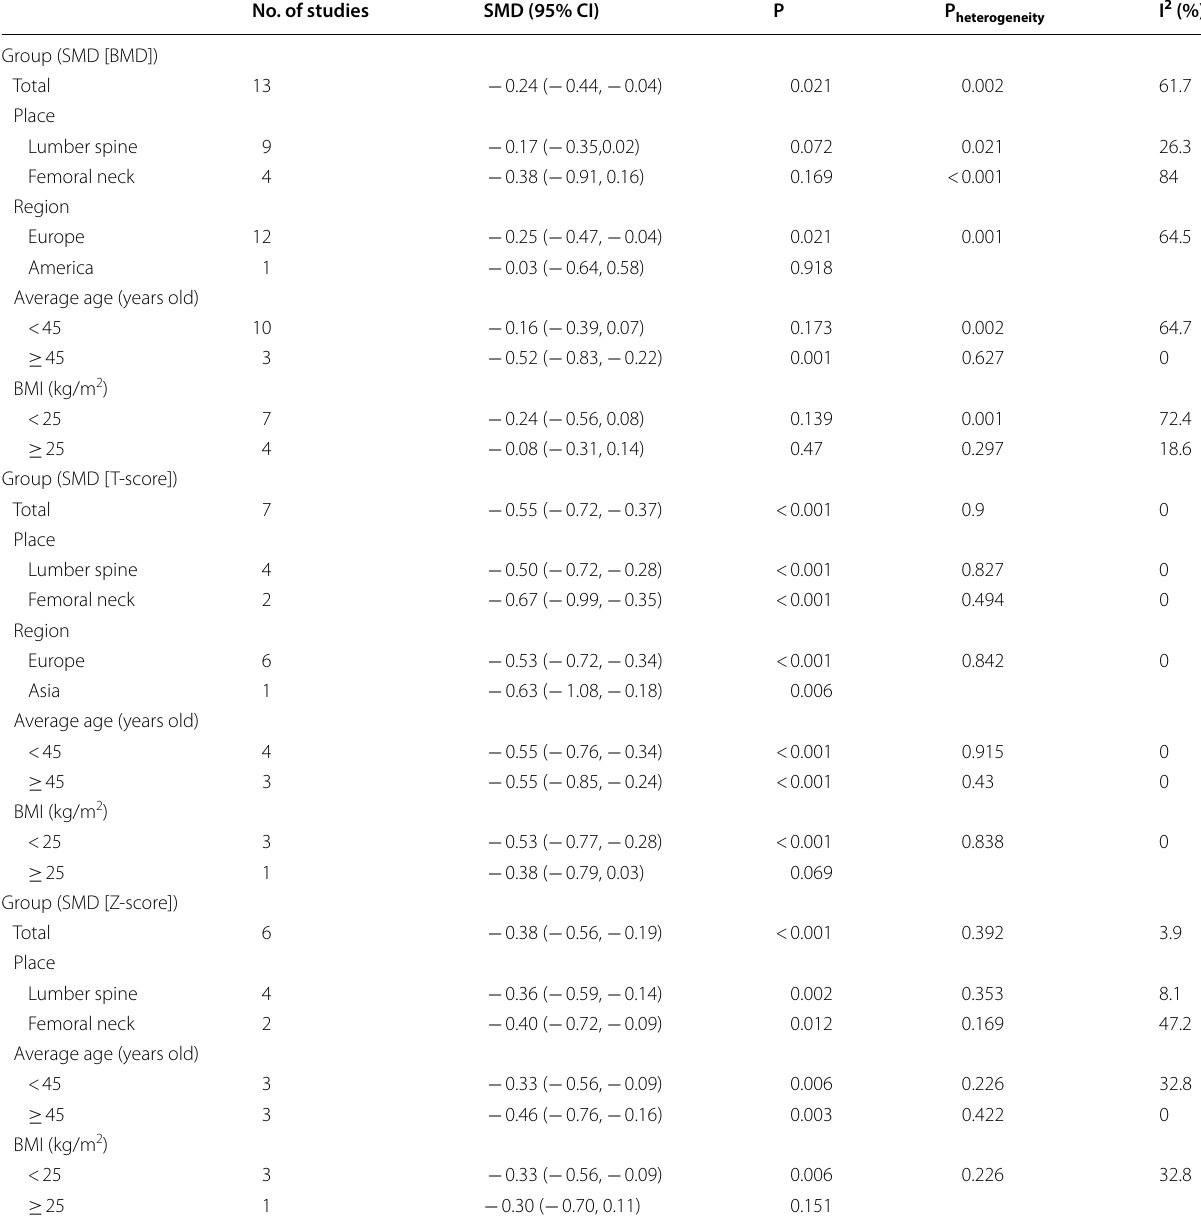
Table 3 Subgroup analyses of group [SMD (BMD)], group [SMD (t-score)] and group [SMD